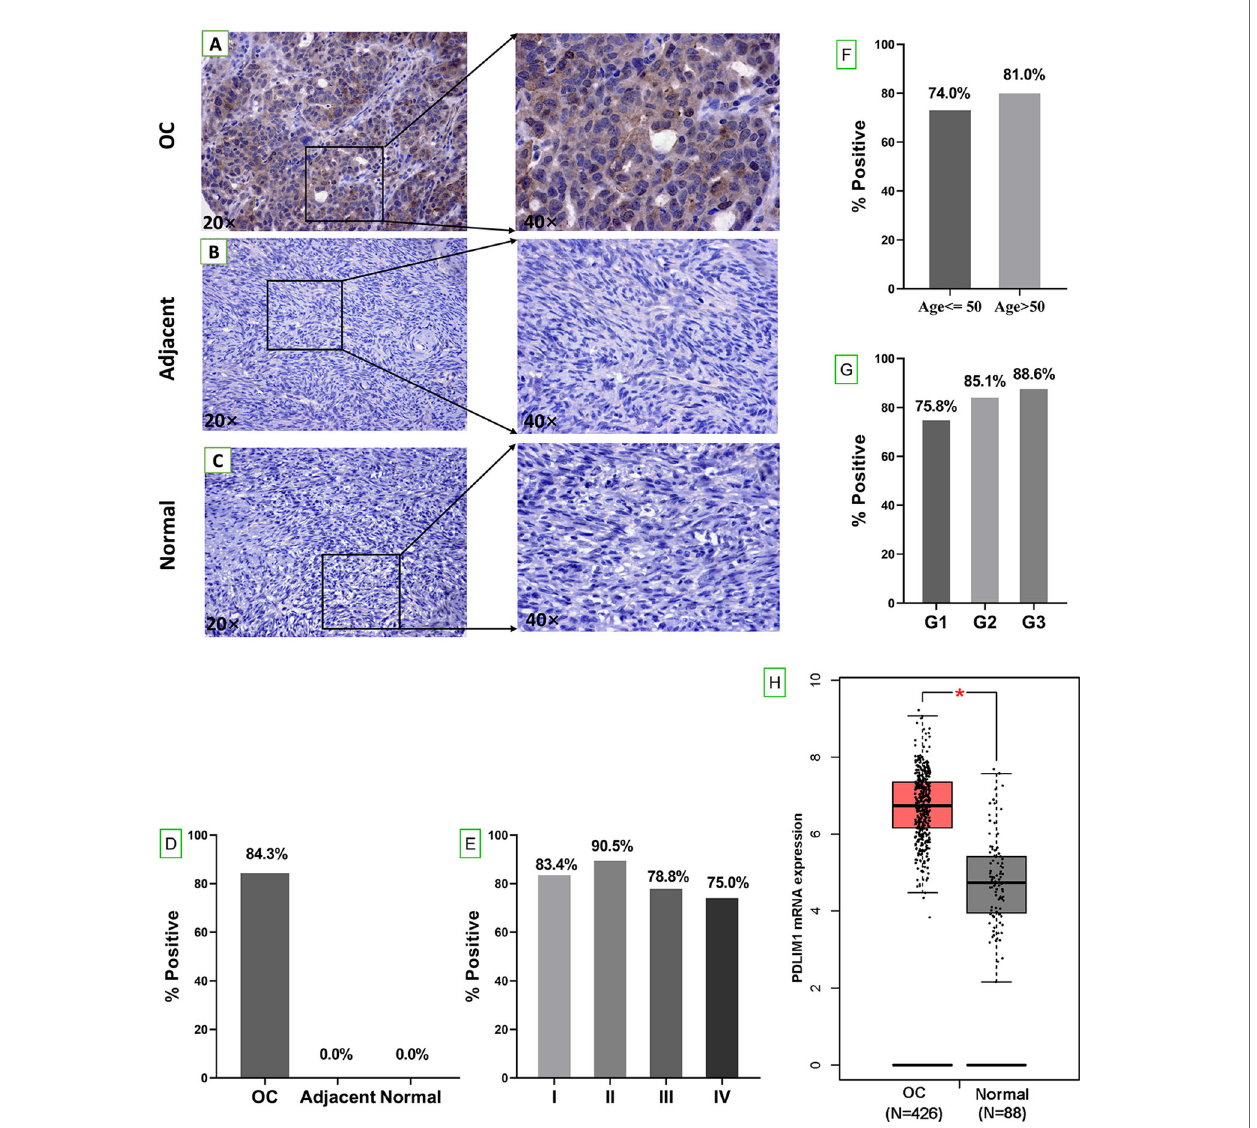
FIGURE 2 | Tissue expression of PDLIM1 by IHC analysis. (A) Positive staining of PDLIM1 in a representative ovarian cancer tissue (obtained at 20× and 40× by microscope). (B) Negative staining in a representative adjacent tissue (obtained at 20× and 40× by microscope). (C) Negative staining in a representative normal ovarian tissue (obtained at 20× and 40× by microscope). (D) Positive rates of PDLIM1 in the tissues of 280 OC, 20 adjacent normal tissues, and 8 normal ovarian tissues. (E) Positive rates of PDLIM1 in the different stages of 280 OC. (F) Positive rates of PDLIM1 in different ages. (G) Positive rates of PDLIM1 in different pathological grades. (H) The mRNA expression of PDLIM1 in OC and normal tissues from GEPIA database. * p < 0.05. The cut-off value was considered as IHC-score